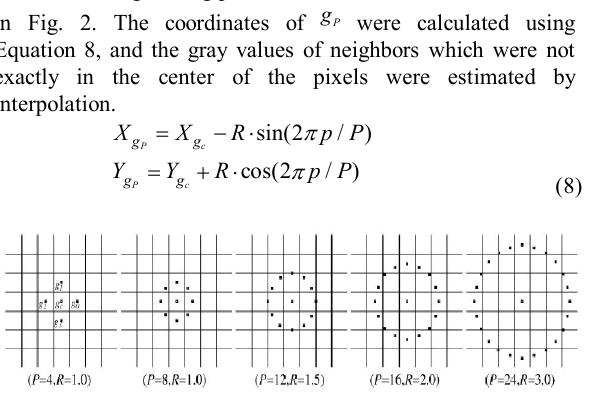
Figure 1: Circularly symmetric neighbor sets for different (P, R)(Ojala,